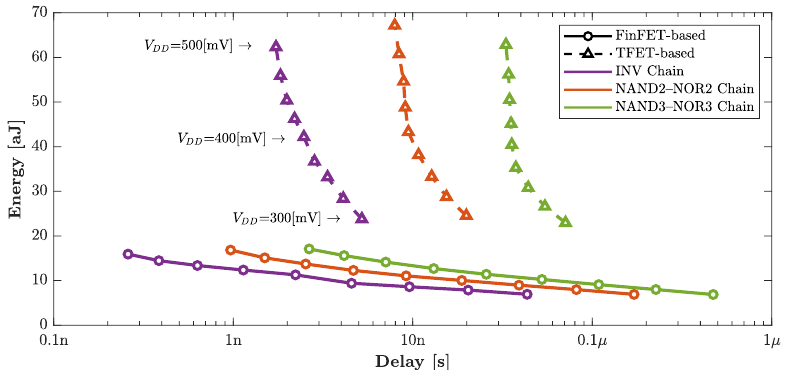
Figure 4. Energy–delay plot over a supply voltage range from 300 mV to 500 mV for TFET and FinFET-based chains made out of inverters (INV), NAND2–NOR2, and NAND3–NOR3